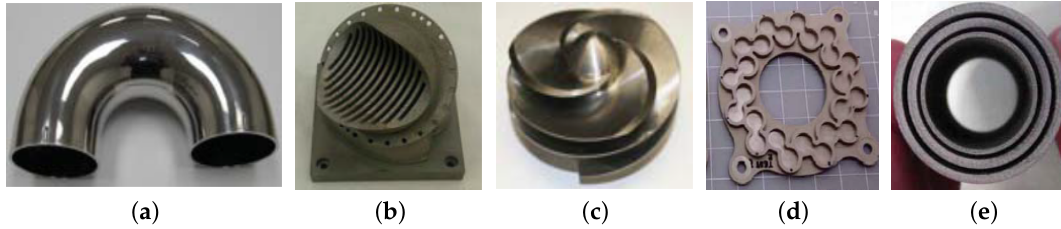
Figure 8. Cost-effective examples of additive manufactured parts: ( a ) a J-2X Gas Generator Duct; ( b ) a Pogo Z-Baffle; ( c ) a Turbopump Inducer; ( d ) a battery case; and ( e ) heat switch prototype